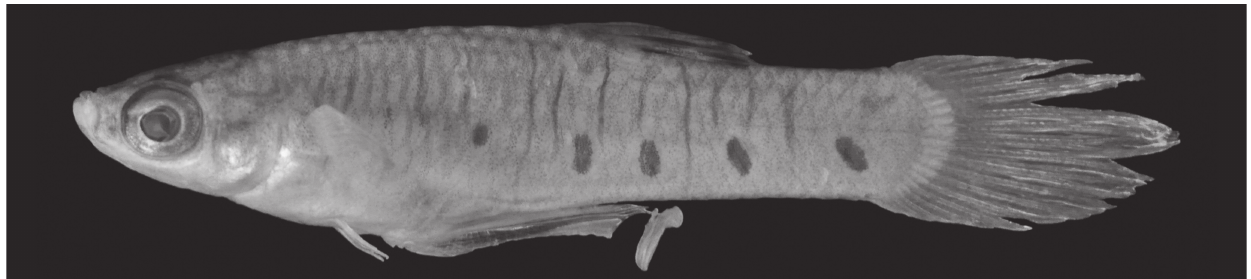
Diagnosis of male specimens . Male specimens of Phallotorynus pankalos can be distinguished from males of its congeners, except P. jucundus Ihering: (1) by the color pattern (six to nine dark brown round spots along lower half of flanks vs . one or two dark brown round to elliptical spots, respectively); (2) by the size of the lateral processes on the trowel-like appendix (large vs . small, respectively); (3) and by left and right halves of the trowel-like appendix united along its whole extension ( vs . halves not entirely united and separate by a gap along its extension). A densely pigmented dorsal fin also distinguishes male P. pankalos from the males of remaining species in the genus,